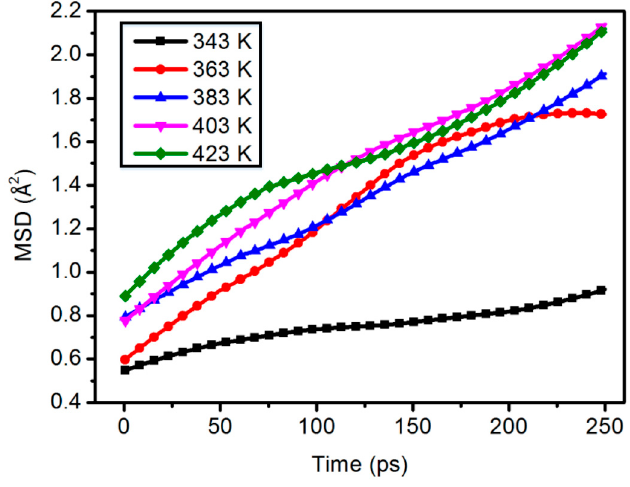
Figure 8. Chain motion of the 7.2 wt % content composite model.